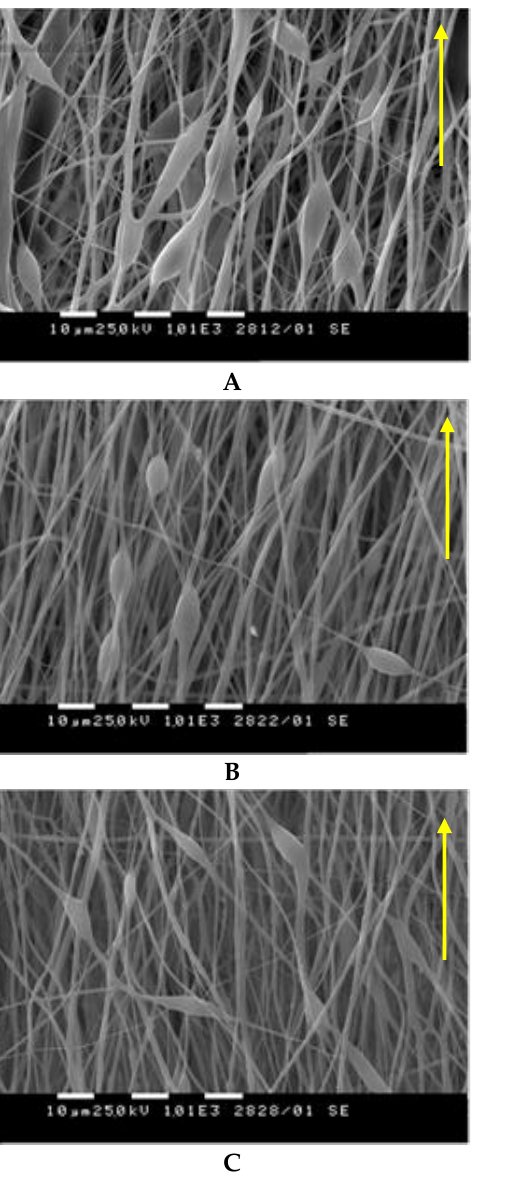
5 of 11 Figure 3. Schematic representation of the working hypothesis.